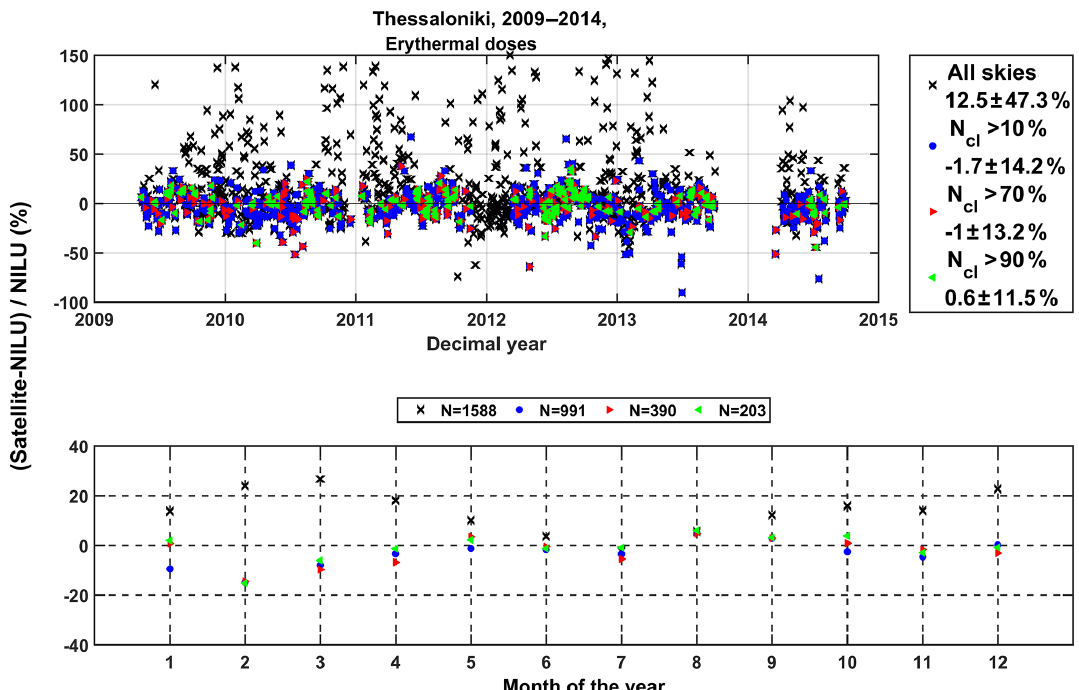
Figure 9. Time series of the relative differences between the satellite-based and ground-based retrieval of the UV erythemal doses; a clas- sification of the cloudless measurements per day is also shown along with the corresponding statistics (upper panel). The seasonality of the data is also presented as monthly mean values (lower panel). Table 3. Statistical analysis of the relative percentage differences [(satellite − ground)/ground%] between the satellite and ground estimates based on the cloudless instances within a day; the all-sky values are given in Figs. 6 and 7. Erythemal doses Vitamin D doses DNA-damage doses Cloudless instances per day (%) > 90% > 70% > 10% >